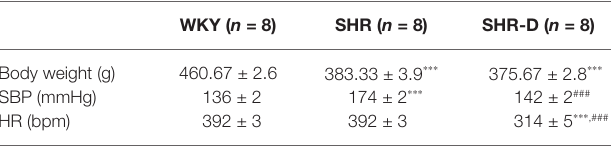
TABLE 1 | Weight, heart rate, and systolic blood pressure from all groups.